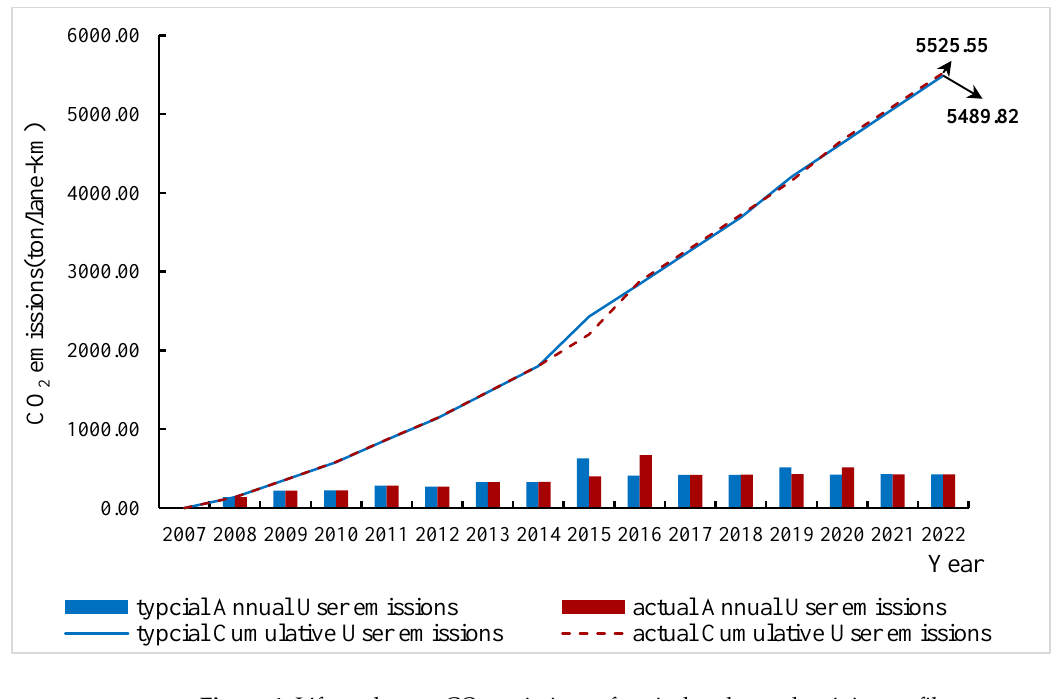
Figure 4. Life-cycle user CO 2 emissions of typical and actual activity profiles.